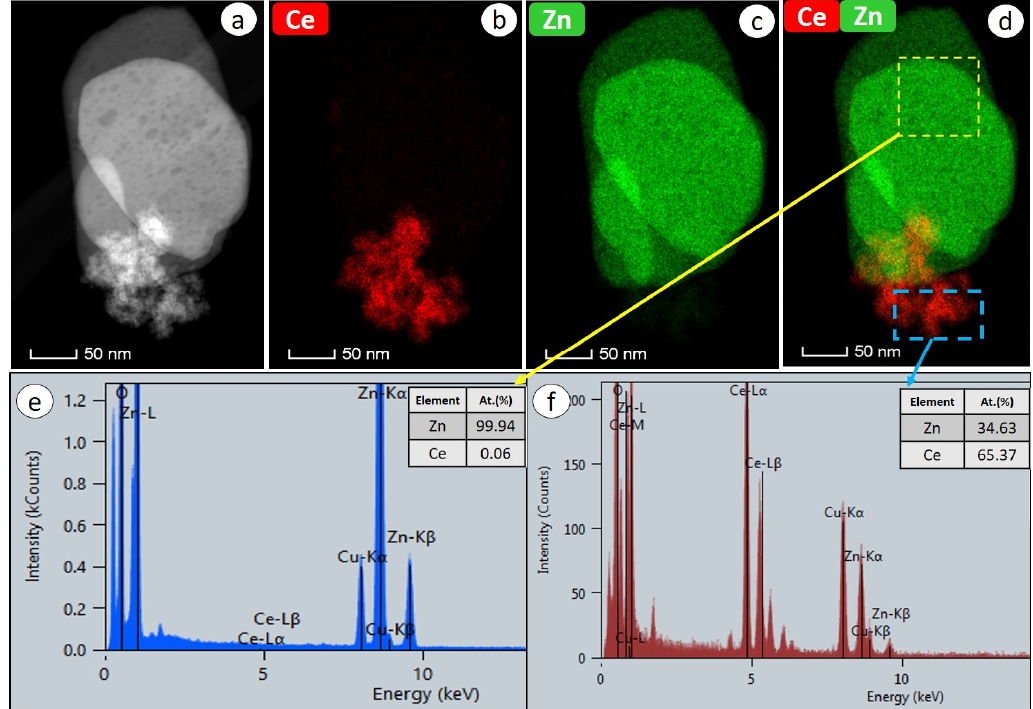
Figure 5. Sample ZnO:Ce 1% . ( a ) HAADF-STEM image and the XEDS elemental maps showing the spatial distribution of ( b ) Ce, ( c ) Zn and ( d ) both elements together corresponding to the area displayed in ( a ), ( e , f ) and the XED spectra of the areas marked in ( d ).